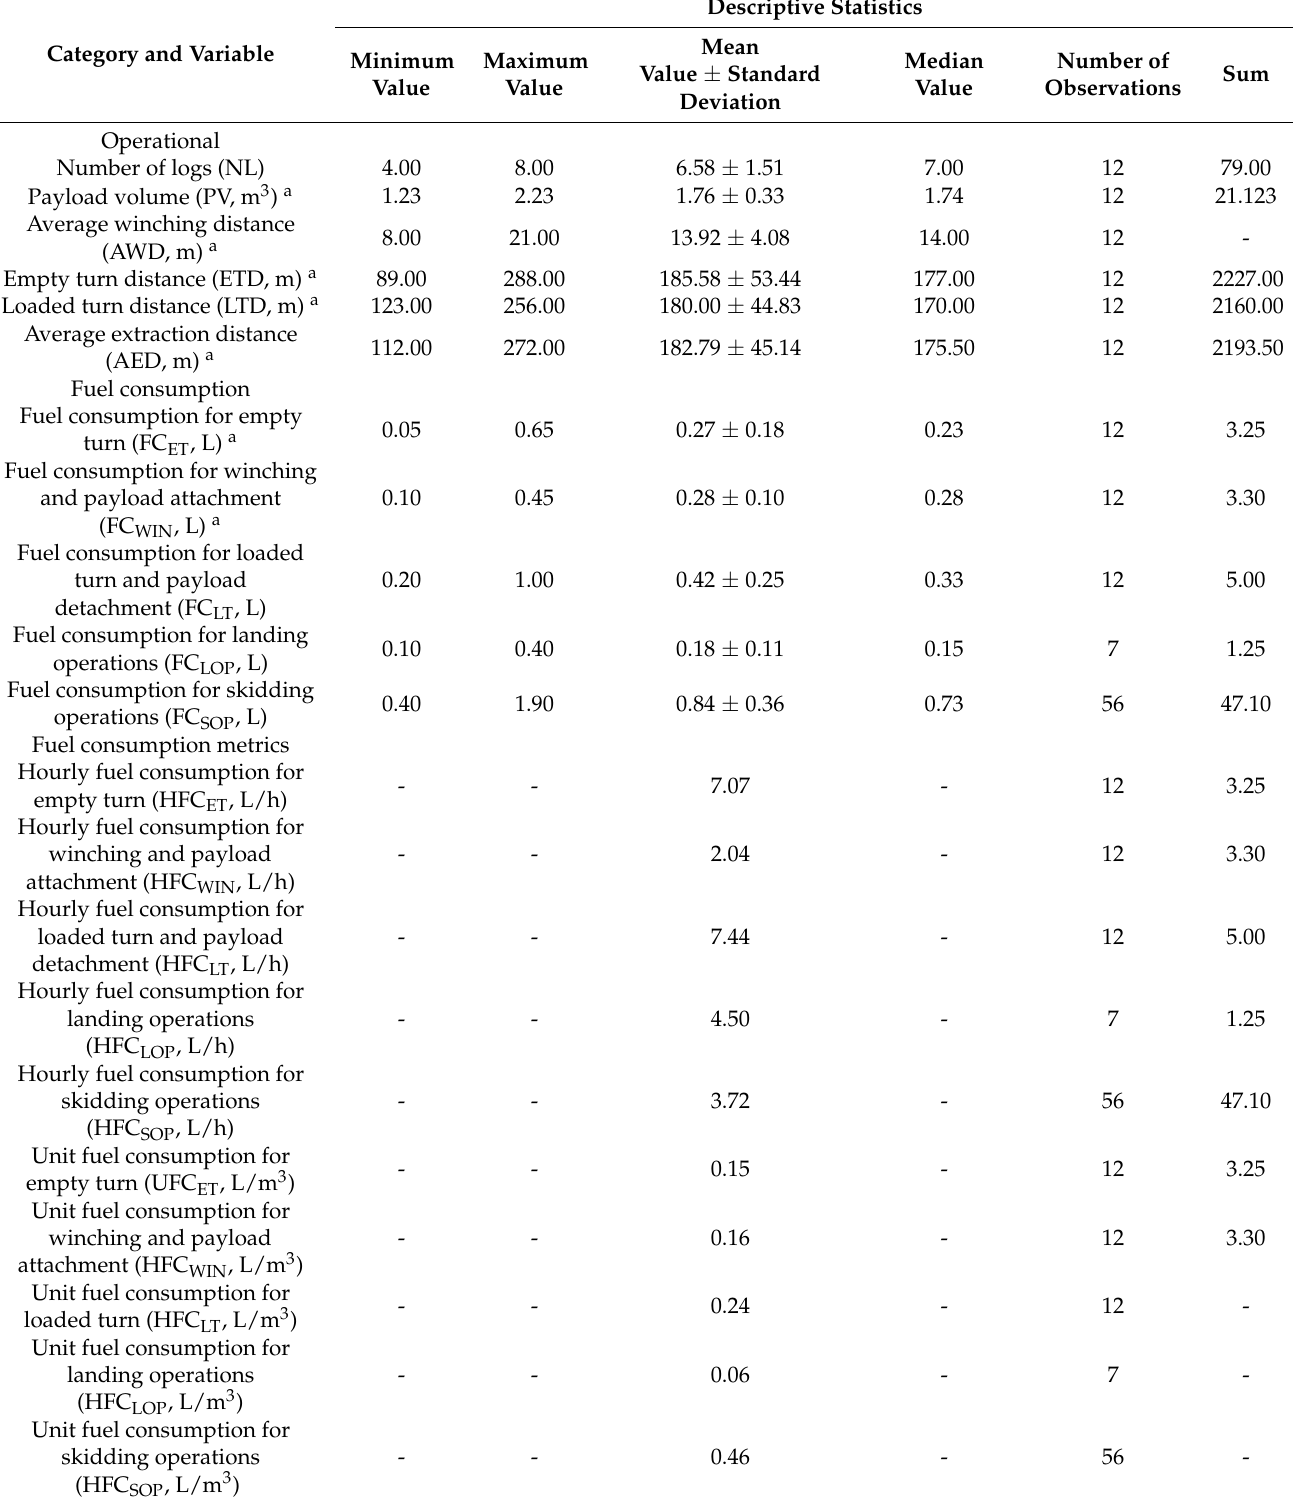
Table 8. Descriptive statistics of operational and fuel consumption variables for skidding